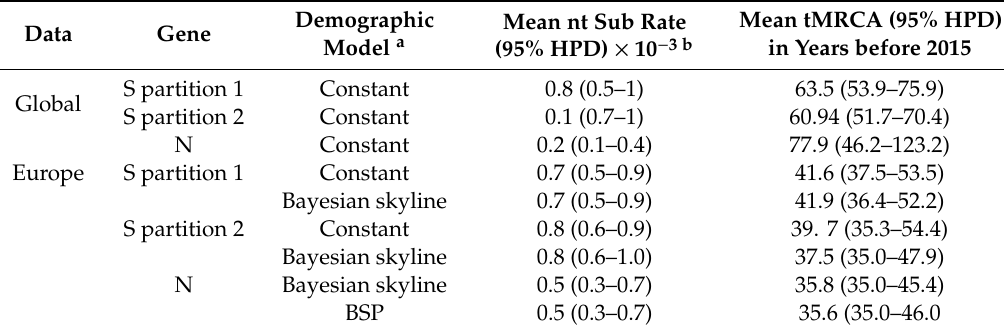
Table 2. Evolution rates and TMRCA for N and S gene